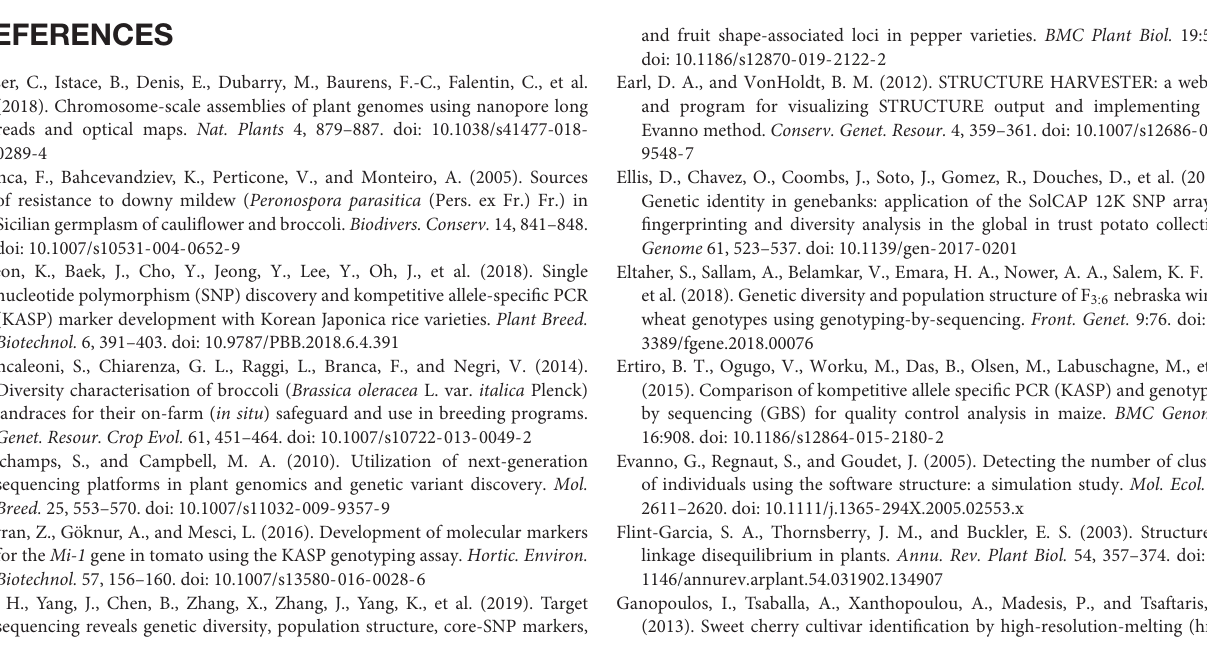
Supplementary Table 5 | Genetic distance across the 372 broccoli accessions.